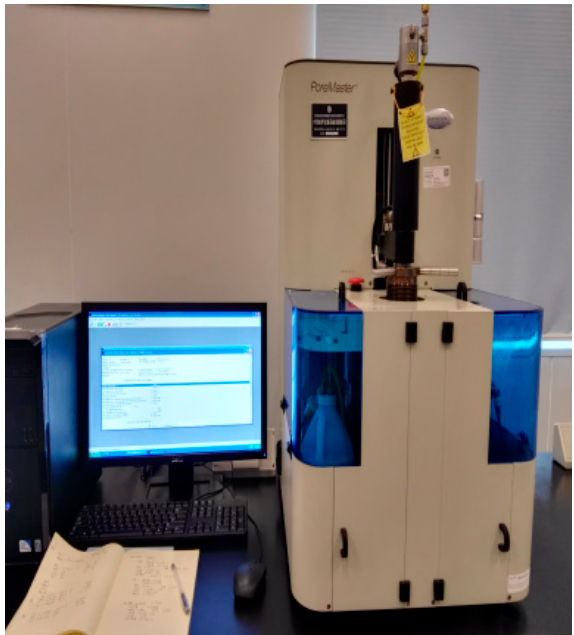
Figure 2. Automatic mercury injection instrument. Rock Triaxial Test System with an electro-hydraulic servo is shown in Figure 3, mainly consists of a power oil source, an axial loading frame, a dynamic confining pressure control system, and an all-digital control system, which is used for uniaxial loading rock mechanical damage tests. When loading, the axial displacement rate is used to control the displacement rate at 0.001 mm/s, and the axial extensometer is used to test the axial deformation of the samples.